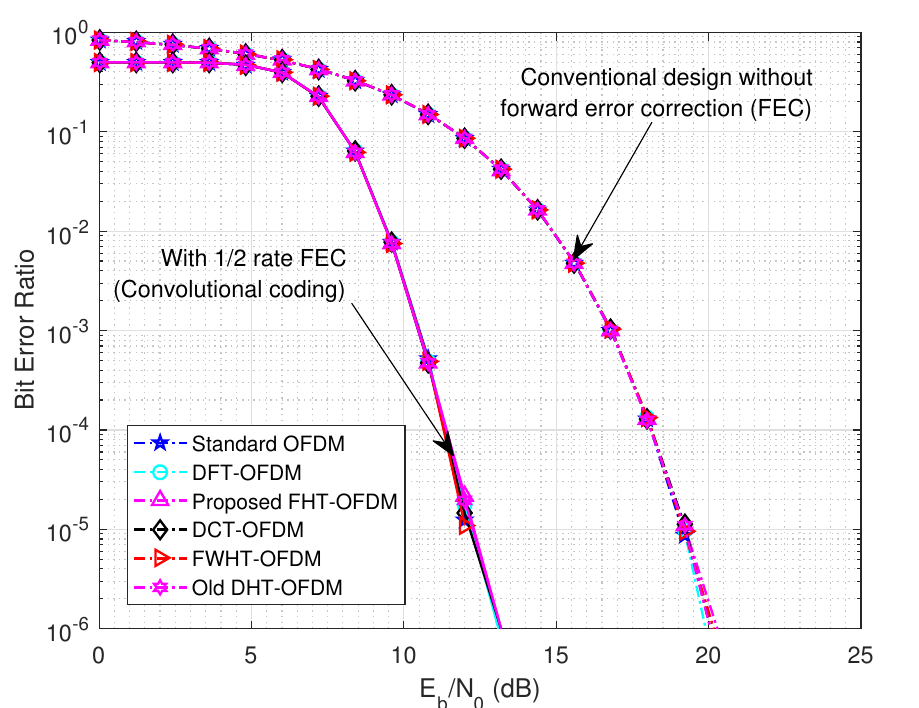
Figure 8. BER results of precoded OFDM (with convolutional coding) over flat fading channel corrupted by AWGN ( (cid:96) h = 1 channel